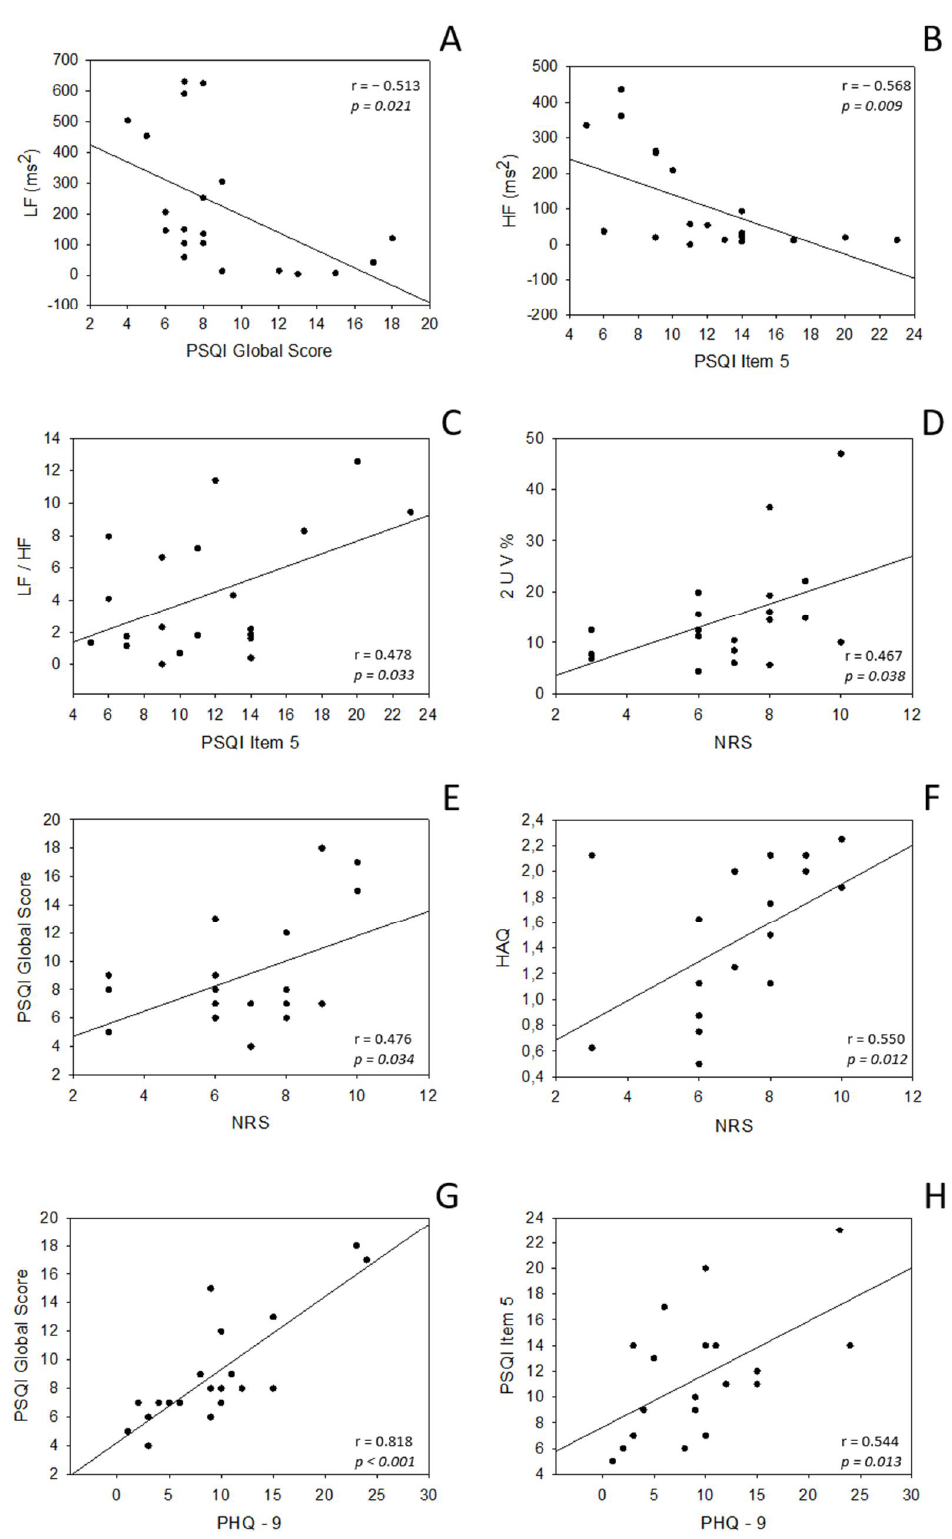
Figure 1. Correlation between cardiovascular parameters and questionnaires scores. Abbreviations: HF, high-frequency band; LF, low-frequency band; nu, normalized units; 2UV%, patterns with 2 unlike variations; NRS, pain score on Numeric Rating Scale; PHQ-9, Patient Health Questionnaire-9 for depressive symptoms; HAQ, index of disability assessed through Health Assessment Questionnaire; PSQI, Pittsburgh Sleep Quality Index. Significant p values < 0.05.